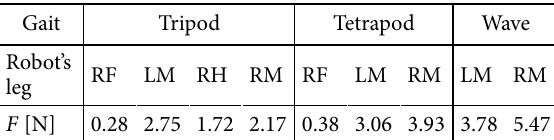
Table 2. Force peak values for different gaits